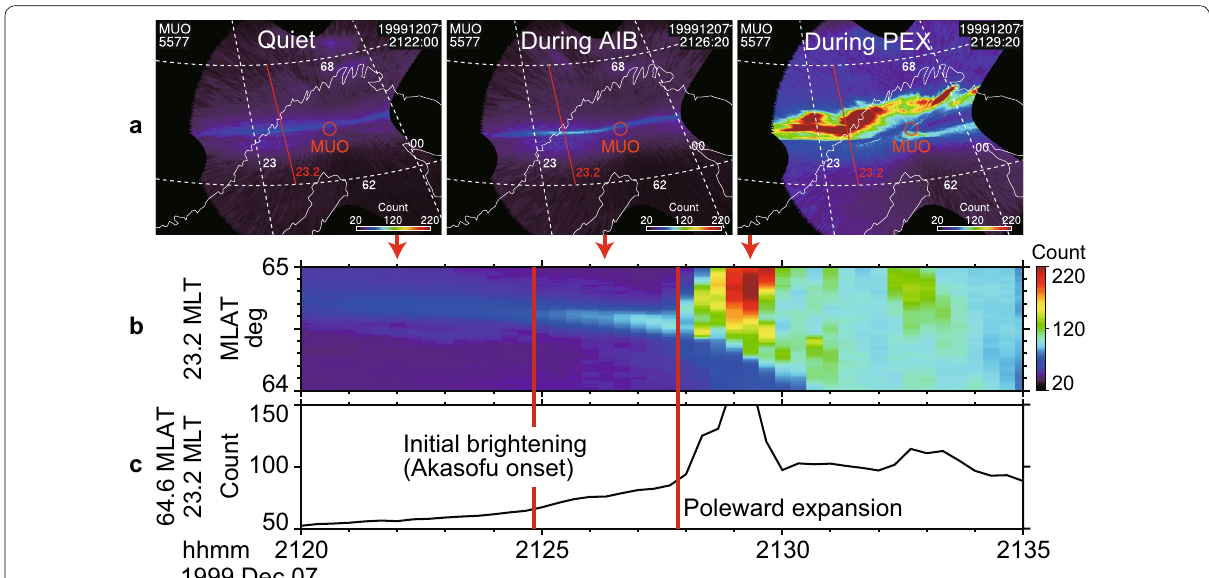
Fig. 5 Ground-based all-sky images (ASIs) near the substorm onset location on December 7, 1999. Auroral brightness at a wavelength of 557.7 nm (green-line) observed at Muonio (MUO) in Finland is shown. a Selected images that represent three intervals as labeled, shown in the geodetic coordinates. The white reference lines represent MLTs and MLATs. The red line indicates 23.2 MLT, the approximate location of the initiation of the Akasofu initial brightening (AIB) and the poleward expansion. b Auroral keograms sliced along the onset meridian (23.2 MLT, which correspond to the red lines in a . c Time series of auroral brightness near the onset location (23.2 MLT, 64.6 MLAT), averaged over 23.0–23.4 MLT and 64.5–64.7 MLAT. The red vertical lines in b and c indicate the times of the AIB (2124:50 UT) and the poleward expansion (2127:50 UT) in